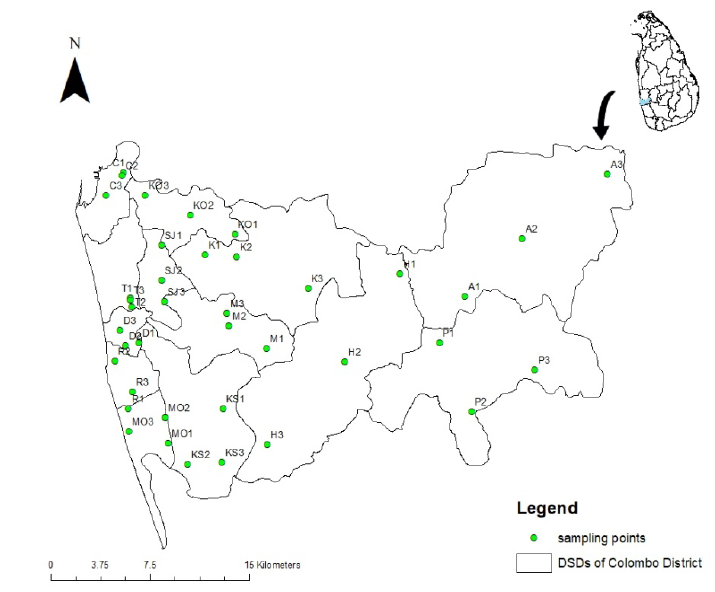
Figure 1: Groundwater sampling sites of the Study